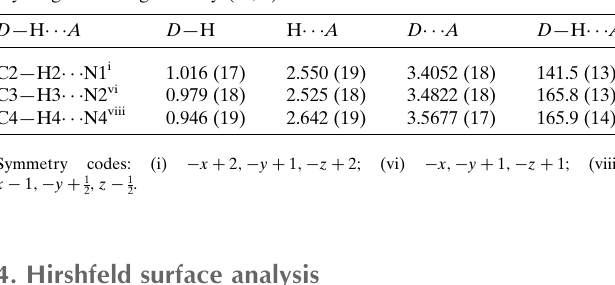
Table 1 Hydrogen-bond geometry (A˚ , (cid:4) ).